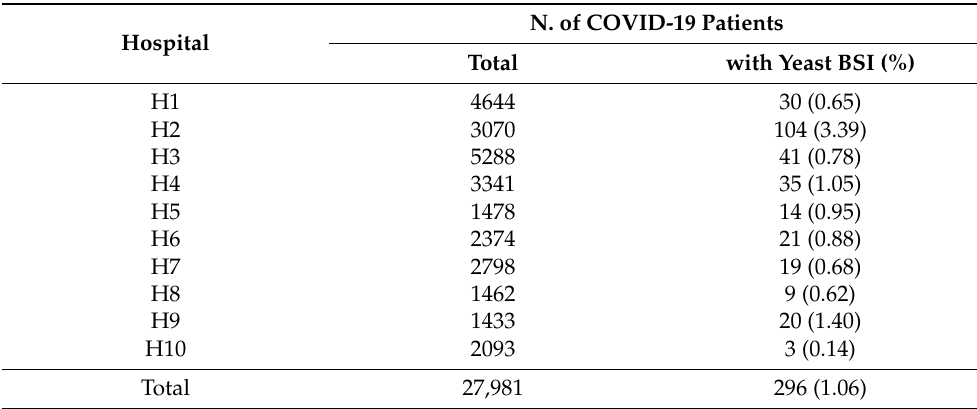
Table 1. Frequency of yeast BSI in the COVID-19 patients hospitalized during the study